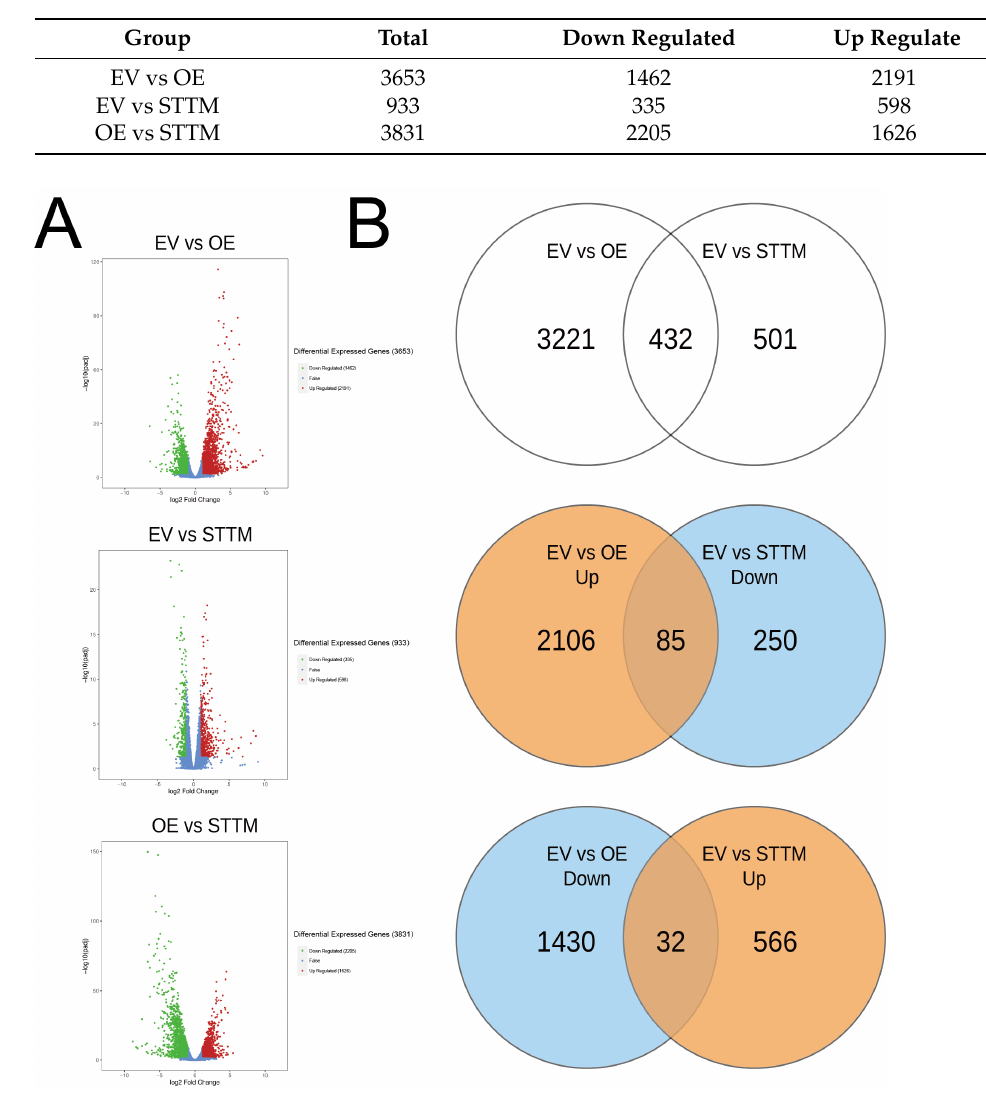
Figure 6. Differential expressed genes analysis in each comparison group. ( A ): The volcano plots show the numbers of significantly differentially expressed genes in each comparison group (padj < 0.05). ( B ): Venn diagrams show the distribution of up and down-regulated genes between EV vs. OE and EV vs. STTM (padj <